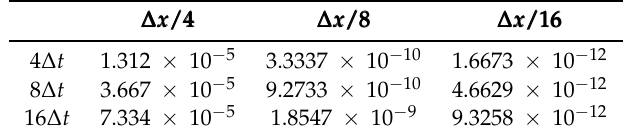
Table 2. Convergence tableau for the ABA-CN-/ABA-iCN-splitting method.